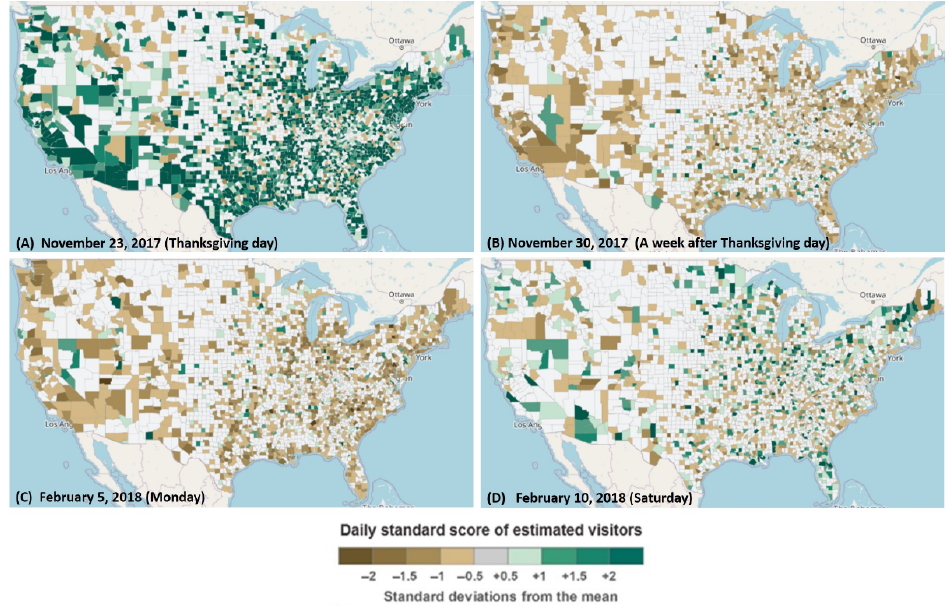
Figure 7. A snapshot of standard score of estimated visitors for four selected days in 2017 and 2018 visualized using the portal, revealing clear holiday and weekday–weekend patterns in a national scale. ( A ) 23 November 2017 (Thanksgiving Day), ( B ) 30 November 2017 (A week after the Thanksgiving Day), ( C ) 5 February 2018 (Monday), ( D ) 10 February 2018